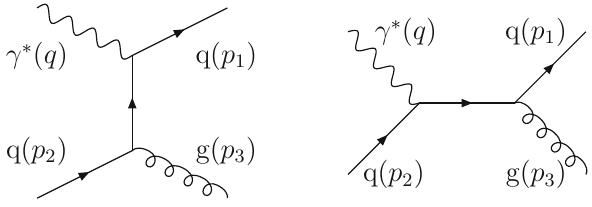
Fig. 6 The two Feynman graphs contributing to the process γ ∗ + q → q + gat O (α em α s ) .Theassignedfour-momentaoftheparticlesaregiven in brackets